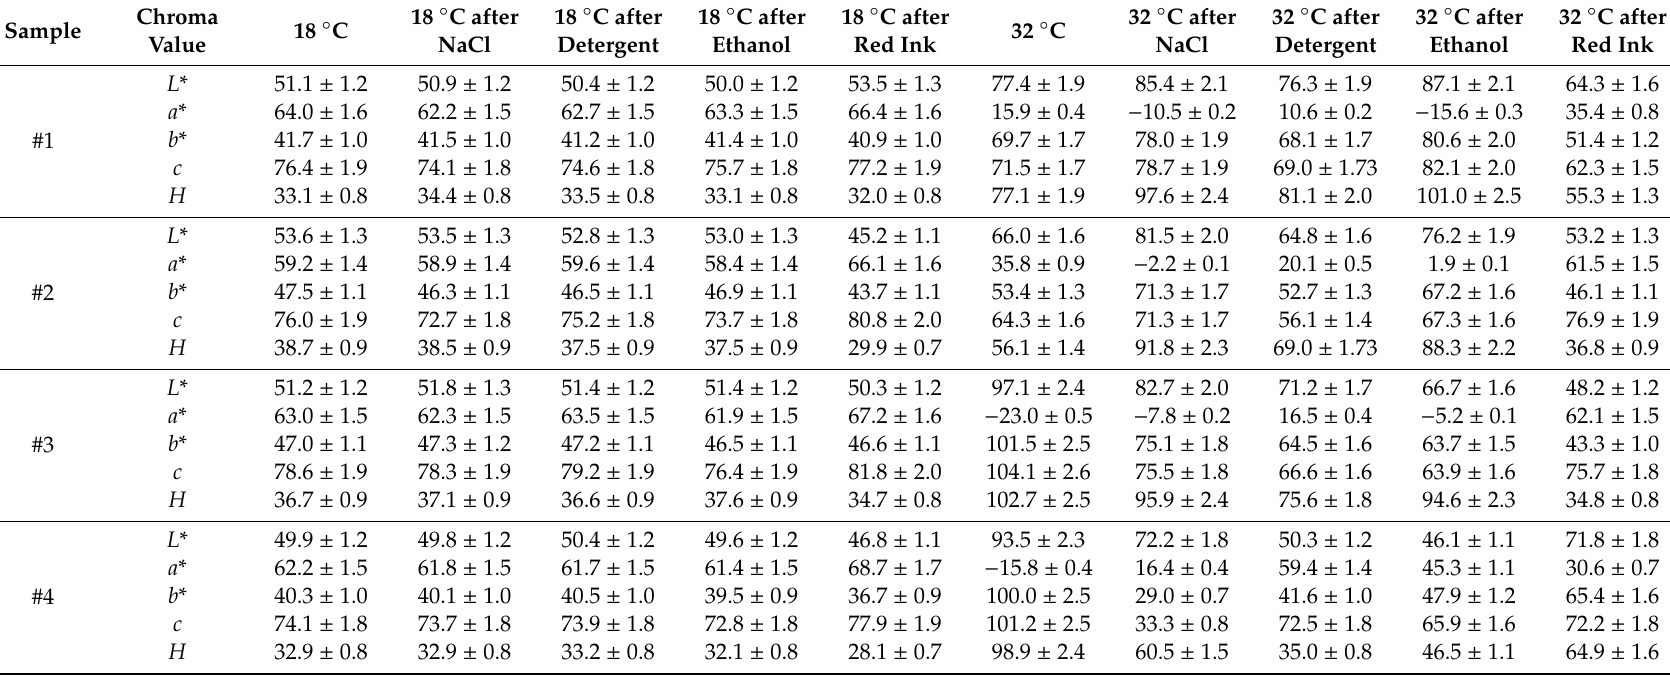
Table 6. E ff ect of the coating process on the liquid resistance color value of the waterborne coating with color-changing powder on Chinese fir.